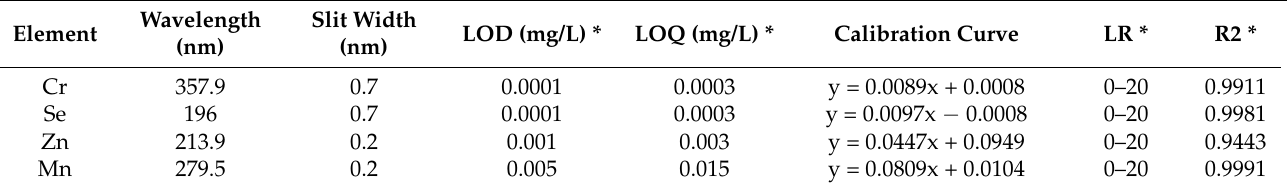
Table 1. Analytical parameters of atomic absorption spectrometer